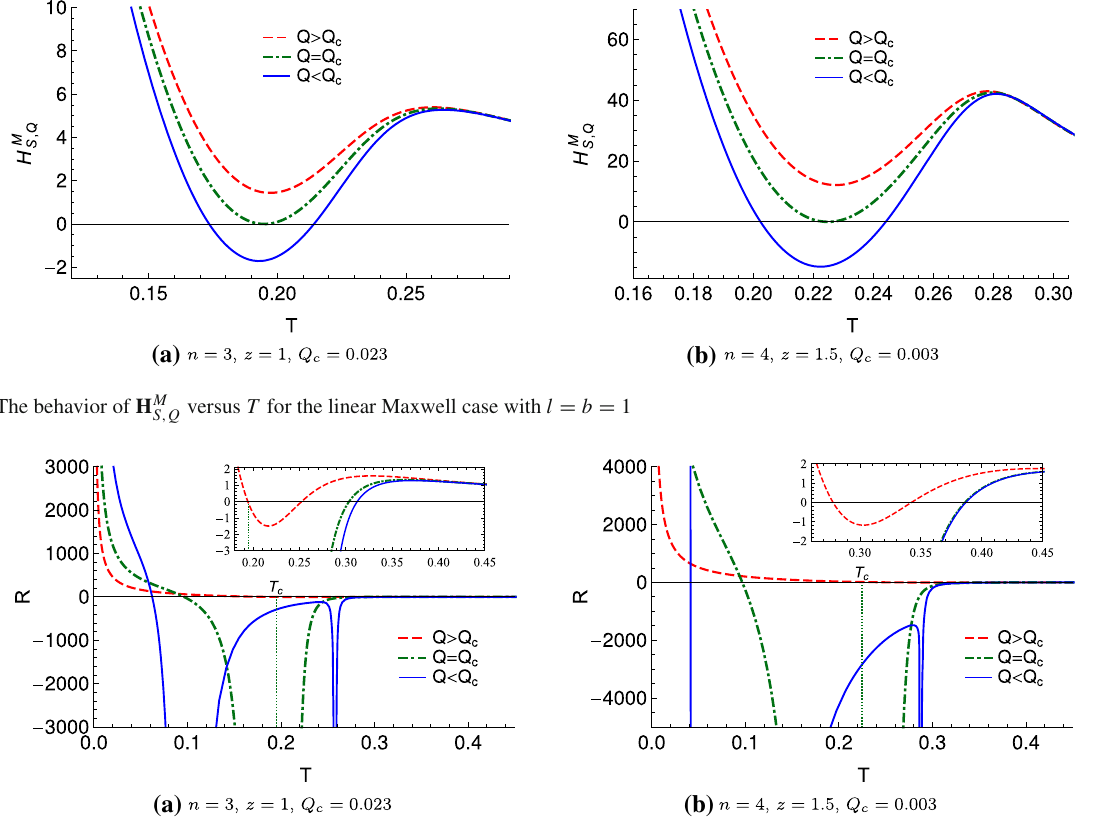
Fig. 6 The behavior of the Ruppeiner invariant R versus T for the linear Maxwell case with l = b =